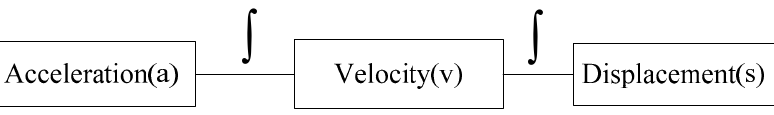
Figure 5. Transformation of coordinates.